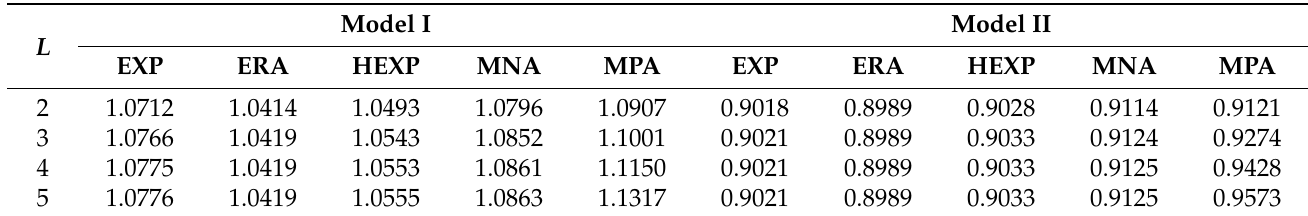
Table 5. Effect of L on expected waiting time of P 1 customers in the system (when θ = 0.6).